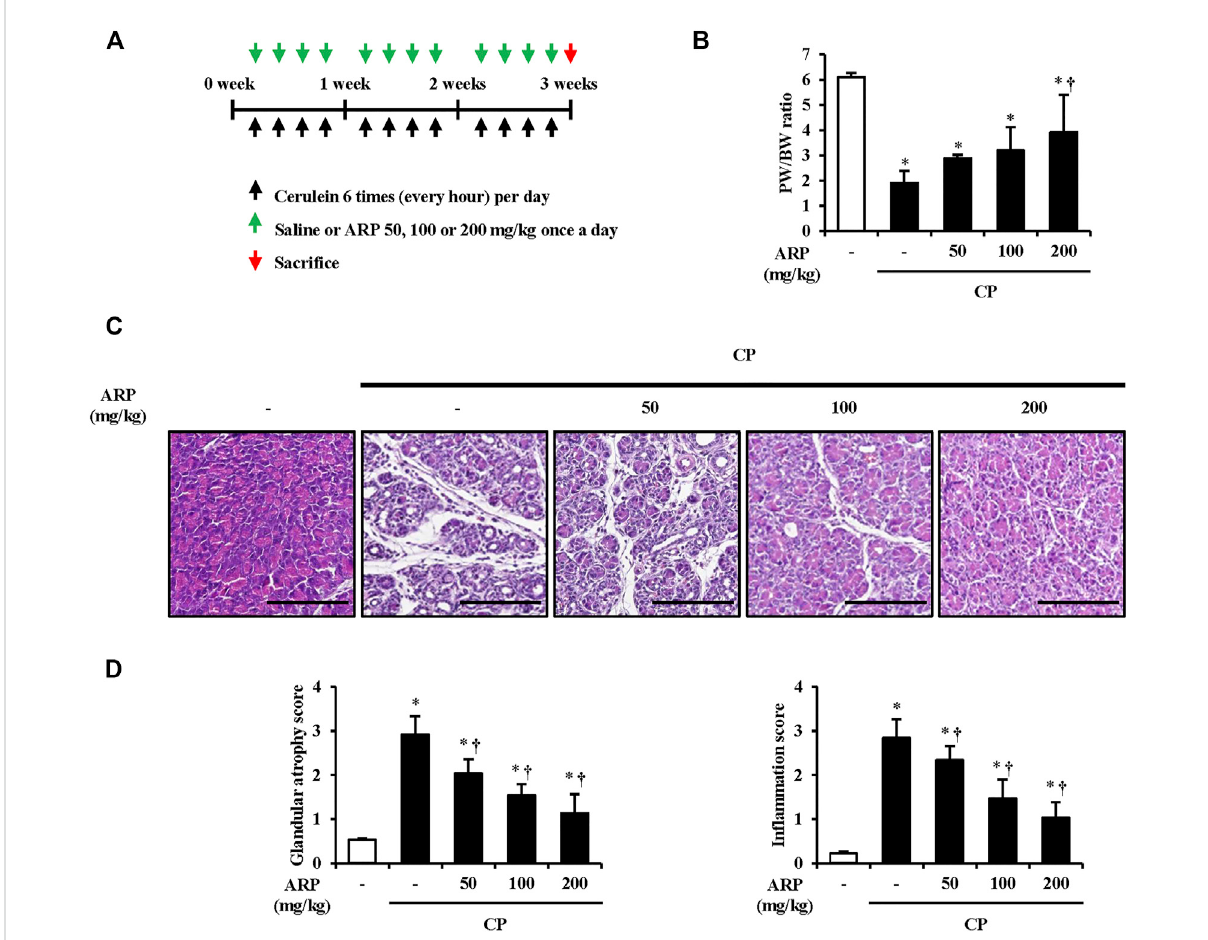
FIGURE 1 Effects of ARP water extract on pancreas morphological change during cerulein-induced CP. (A) Scheme of CP model in mice to examine the prophylactic effect of ARP water extract. (B) Pancreatic weight/body weight ratio in the saline, CP, and ARP groups (50, 100, and 200 mg/kg). (C) Representative Hematoxylin and Eosin-stained sections of the pancreas. (D) Pathological scores of pancreatic tissues. Data are represented as means ± SEM ( n = 3 per group). Results are representative of three experiments. * p < 0.05 vs saline alone; † p < 0.05 vs. CP. Original magni fi cation, ×400. Scale bar = 50 μ